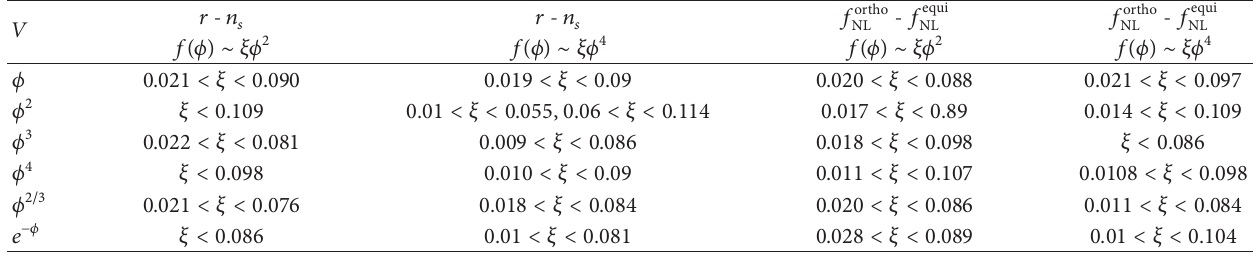
Table 2: The ranges of 𝜉 in which the values of the inflationary parameters 𝑟 and 𝑛 𝑠 and also 𝑓 ortho NL and 𝑓 equi NL , with 𝑛 = 2 , are compatible with the 95 % CL of the Planck 2015 dataset.